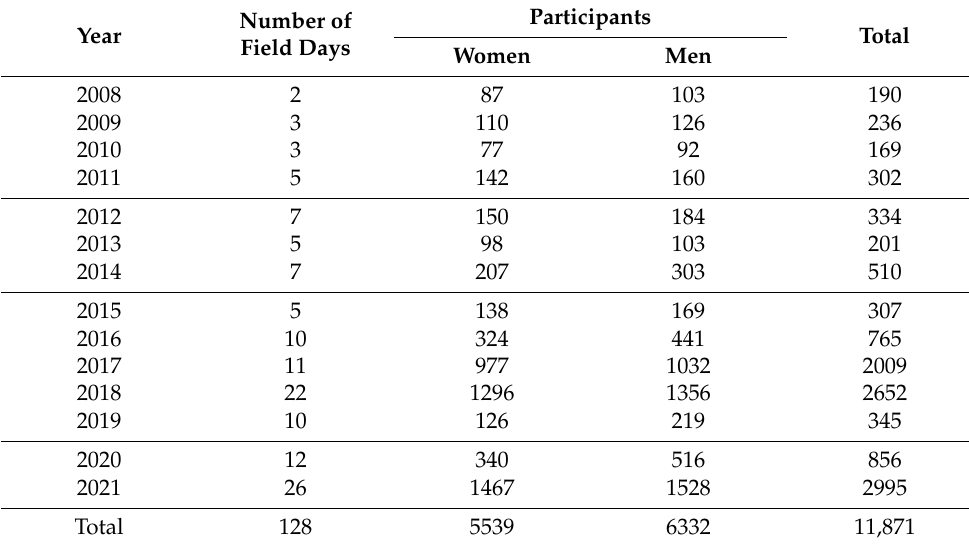
Table 5. Number of field days conducted in